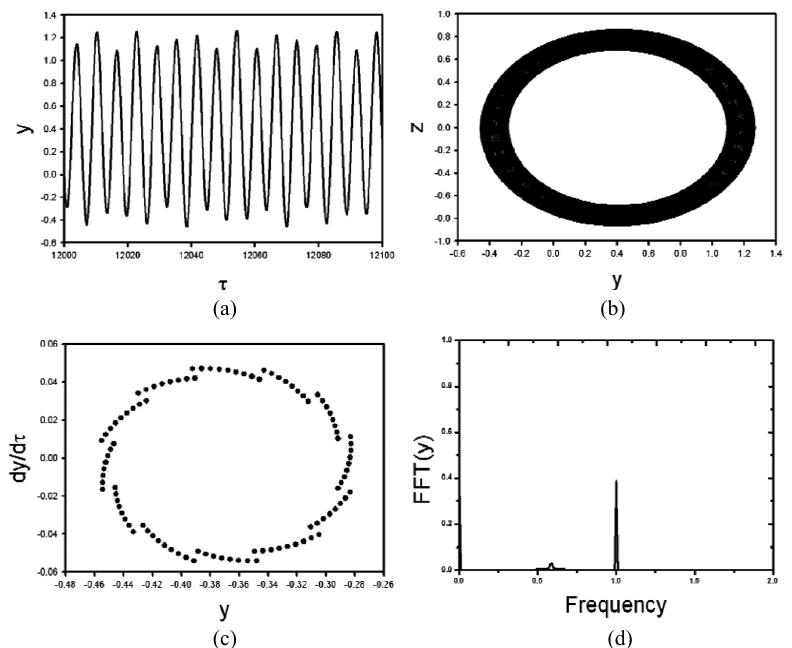
Fig. 15. Dynamic characteristic of the y-displacement of the mid-span point with γ m = 100 T 2 m/H. (a) Time history; (b) Orbital trajectory; (c) Poincar´e section; (d) FFT.